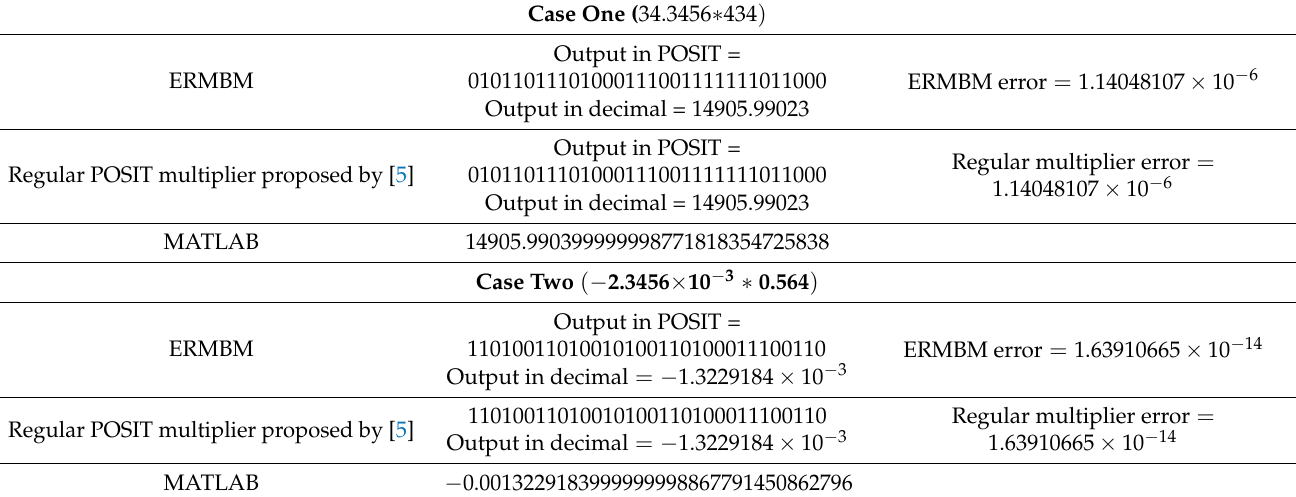
Table 4. A total of three random cases that were tested to compare the accuracy between the arithmetic units ERMBM and the regular